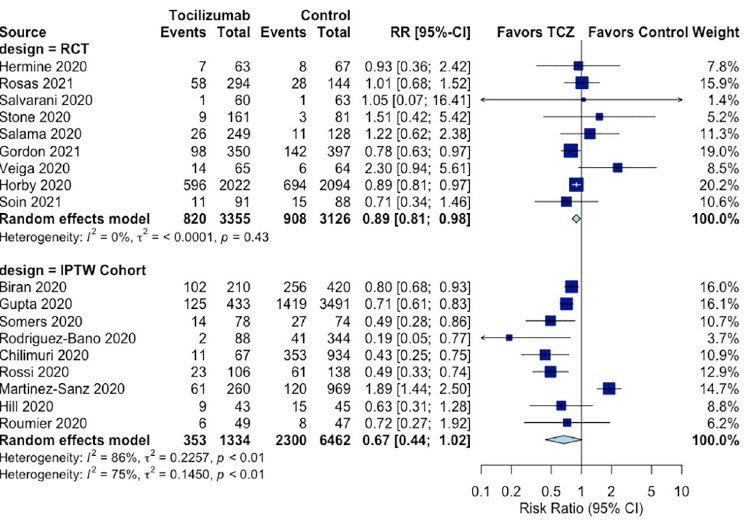
Fig 2. Effect of tocilizumab on all-cause mortality in RCTs and IPTW cohort studies of hospitalized COVID-19 patients.